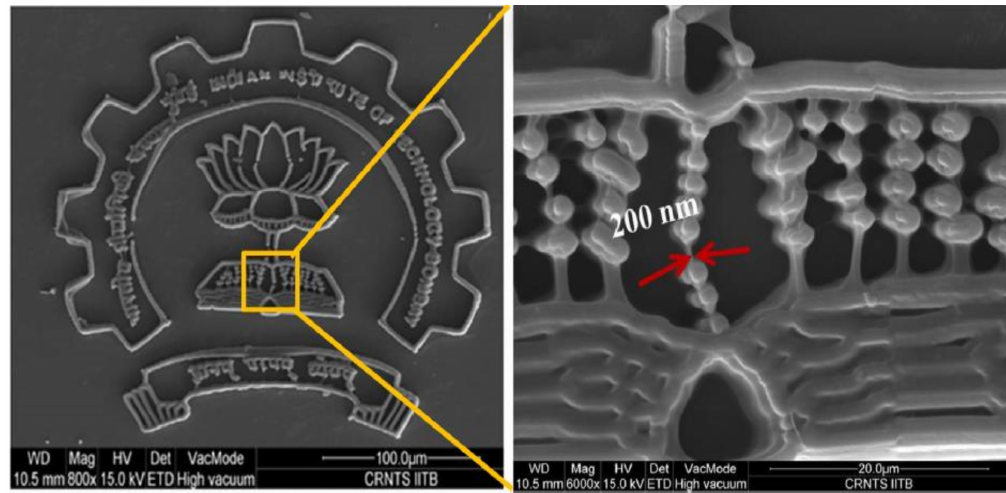
Figure 25. The SEM image of “Technology Bombay” logo with the line width of 200 nm by DLW